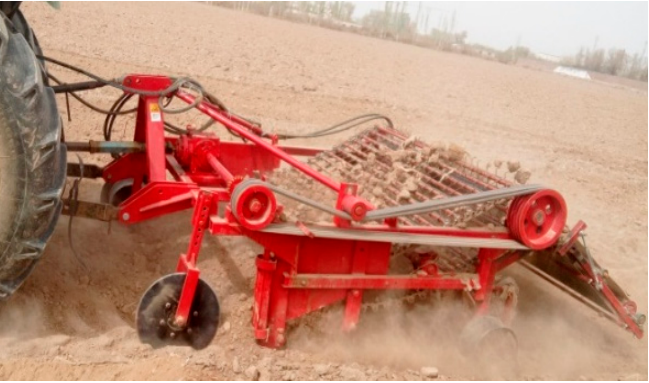
Figure 18. Field experiment of the chain drive residual film recovery mechanism.